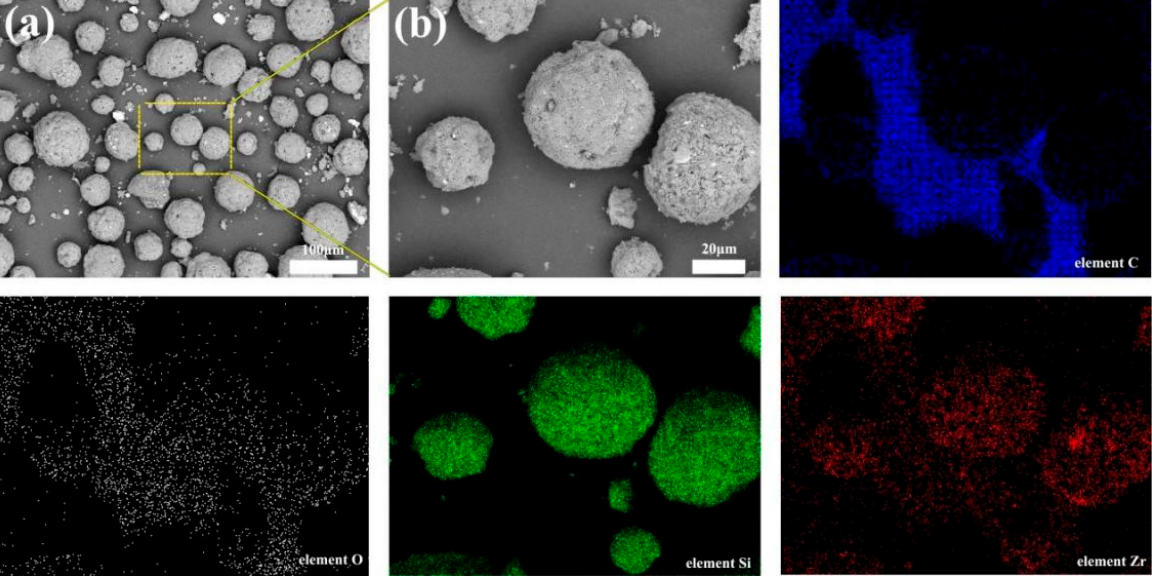
Figure 2. SEM images and EDS analysis of the 20 wt.% ZrSi 2 -80 wt.% SiC particles used for plasma spraying. ( b ) Partially enlarged view of ( a ).